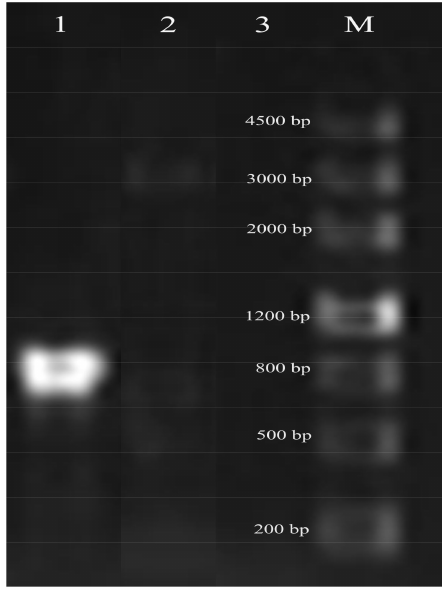
Figure 4. Electrophoresis of prtS gene in S. thermophilus. Lane 1: S. thermophilus KLDS SM; Lane 2: S. thermophilus KDLS3.1012; Lane 3: negative control without the template DNA and Lane M: